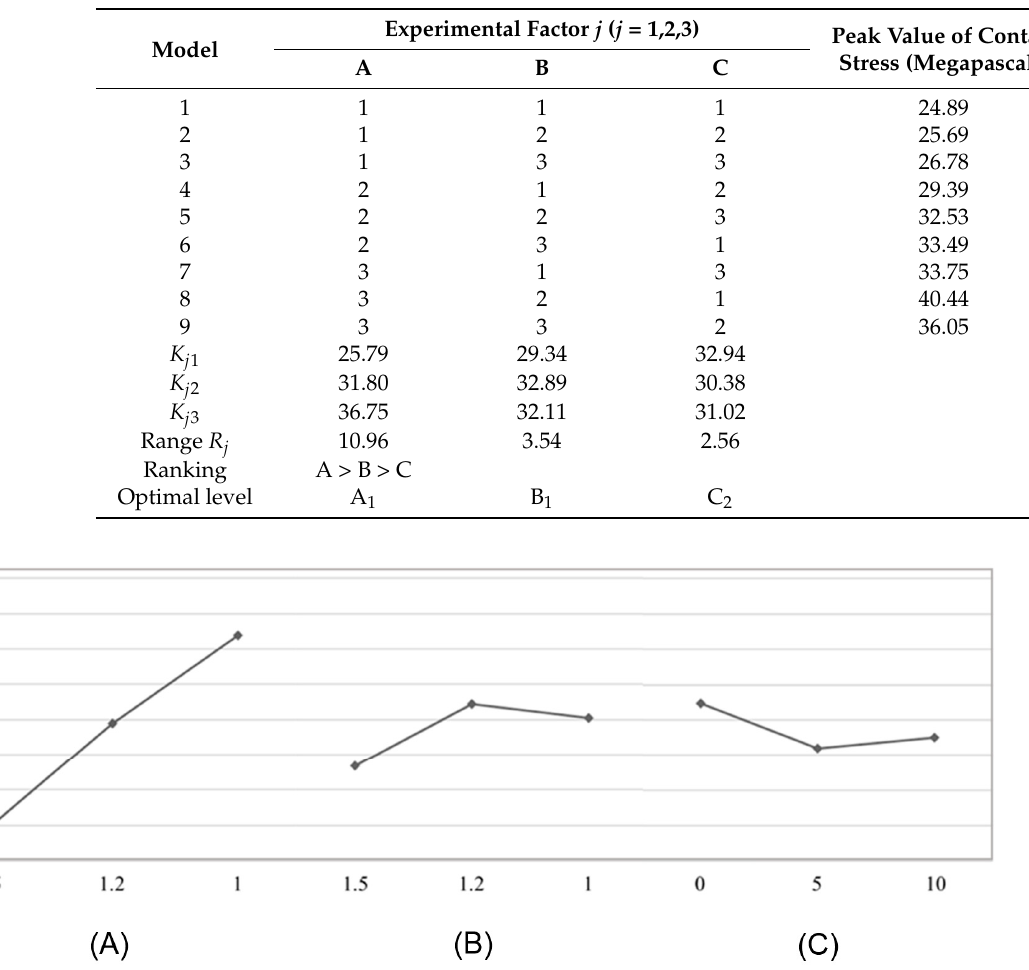
Table 5. Optimisation of the results of the orthogonal experimental design.